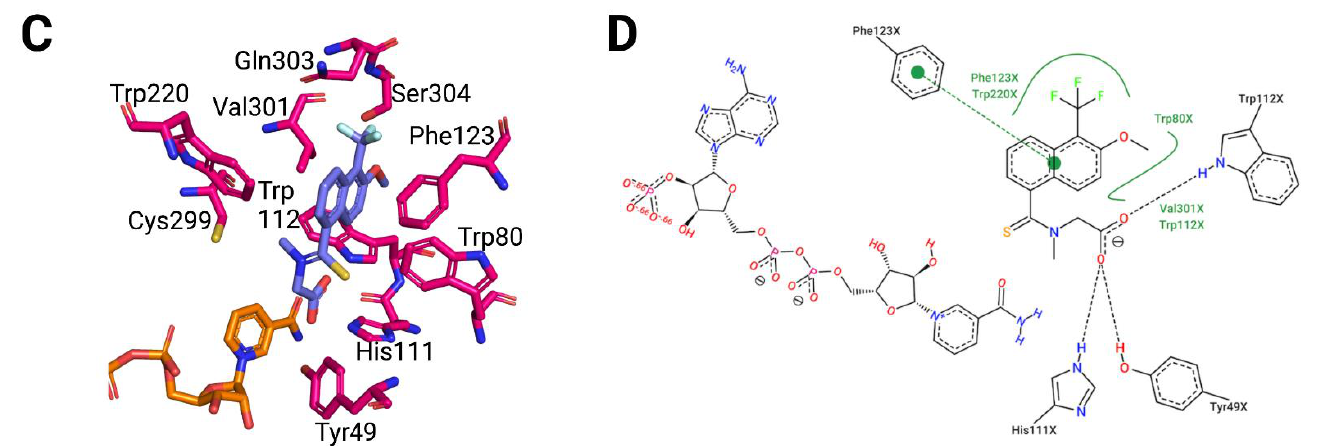
Figure 2. Overview of the AKR1B10 three-dimensional structure. ( A ) Crystal structure of AKR1B10 complexed with NADP + (orange) and tolrestat (violet, PDB ID 1ZUA), with side view of the ( α / β ) 8 barrel, with α helices in red, β sheets in yellow and loops in green. ( B ) Surface representation of the structure, indicating location of the anion-binding pocket (ABP) and specificity pocket (SP). ( C ) Atomic model describing interactions of the tolrestat molecule in the AKR1B10 – NADP + – tolrestat complex. ( D ) 2D representation of the previous. Created with PyMoL 2.3.0. and in biorender.com.